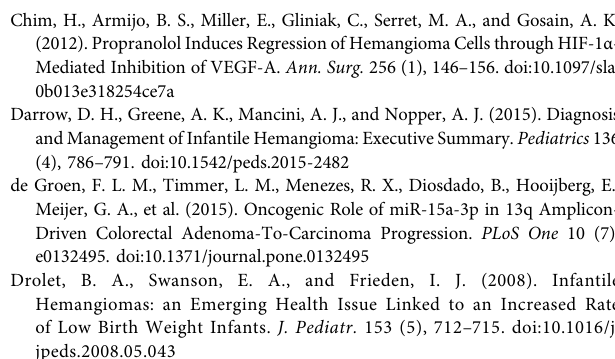
Supplementary Figure S1 | The work fl ow of the methodology used in the study. miRNA(s), micro-RNA(s); IH, infantile hemangioma; DEG, differentially expressed genes between IH and normal tissues; DEM, differentially expressed miRNAs between IH and normal